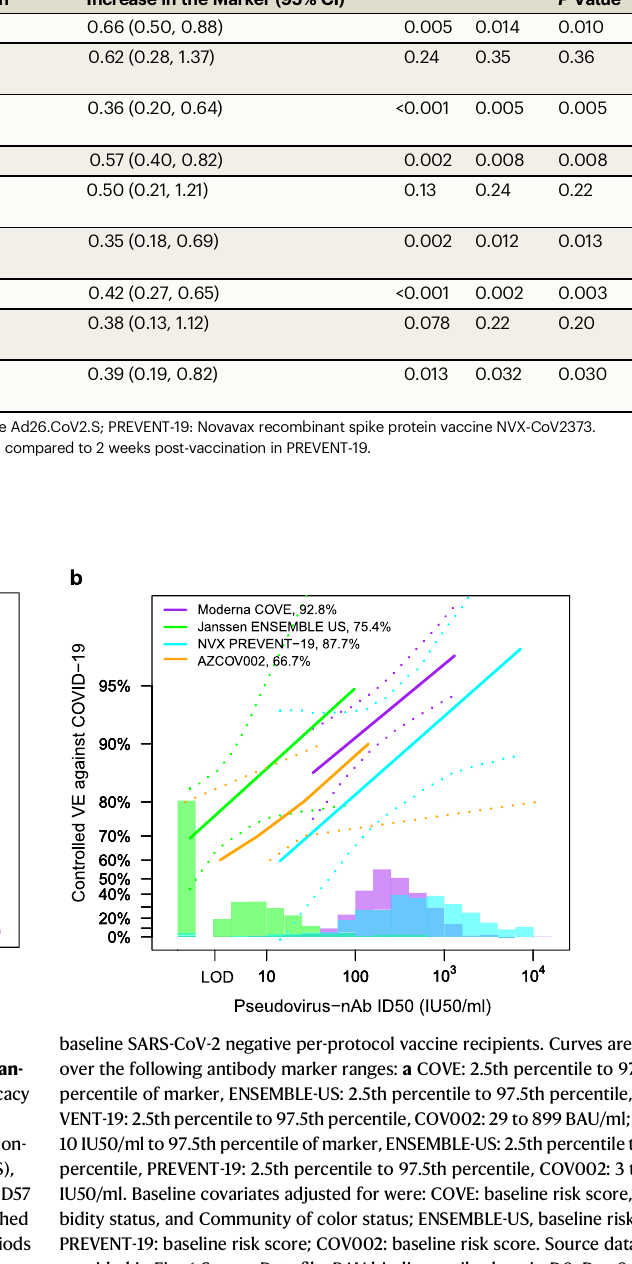
Table 3 | Comparison of correlation of risk results for spike IgG and PsV-nAb ID50 across three randomized, placebo- controlled COVID-19 vaccine ef fi cacy trials (U.S. study sites) Vaccine Platform a Trial Ab Marker at 2 or 4 Wks b Post-Vaccination